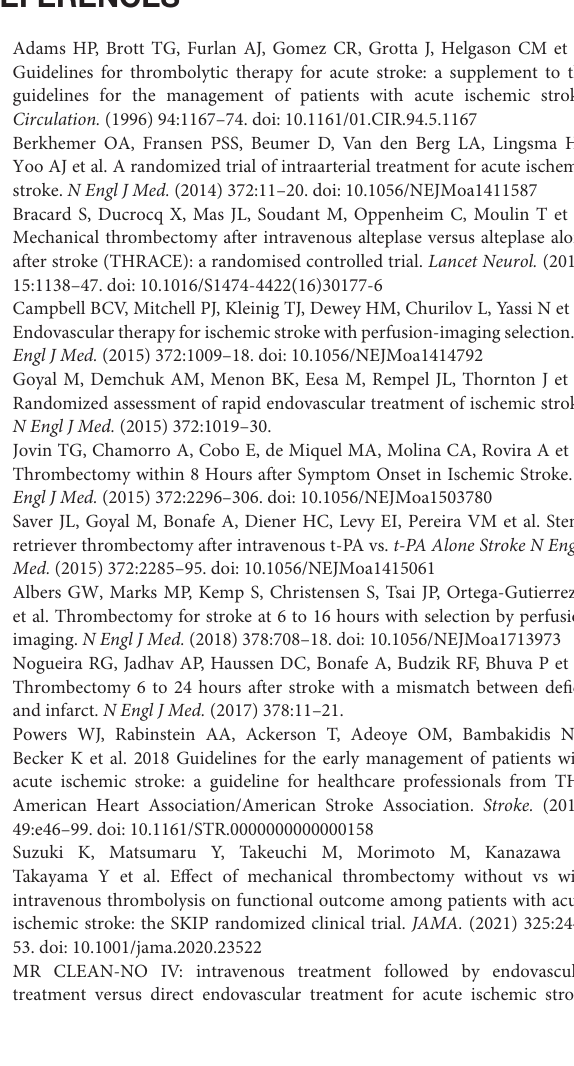
Supplementary Figure 1 | Step-by-step schematic of the systematic review process in Nested Knowledge. The first step is conceiving a study protocol and a nest with arms, baseline variables, and outcomes to guide the rest of the process. This is followed by an semi-automated literature search based on search strings, screening of studies for inclusion, tagging of included studies with relevant labels from the nest, extraction of data, and cursory review of the automated data synthesis prior to a full analysis. Each of these steps is sequentially included in this figure. Supplementary Figure 2 | PRISMA diagram of search records and included studies automatically generated by the AutoLit platform. Supplementary Table 1 | Risk of bias assessment per the Scottish Intercollegiate Guideines Network for the four studies included in this meta-analysis. Supplementary Video 1 | Video walkthrough of the steps in the systematic review process on the Nested Knowledge living platform and other functionality